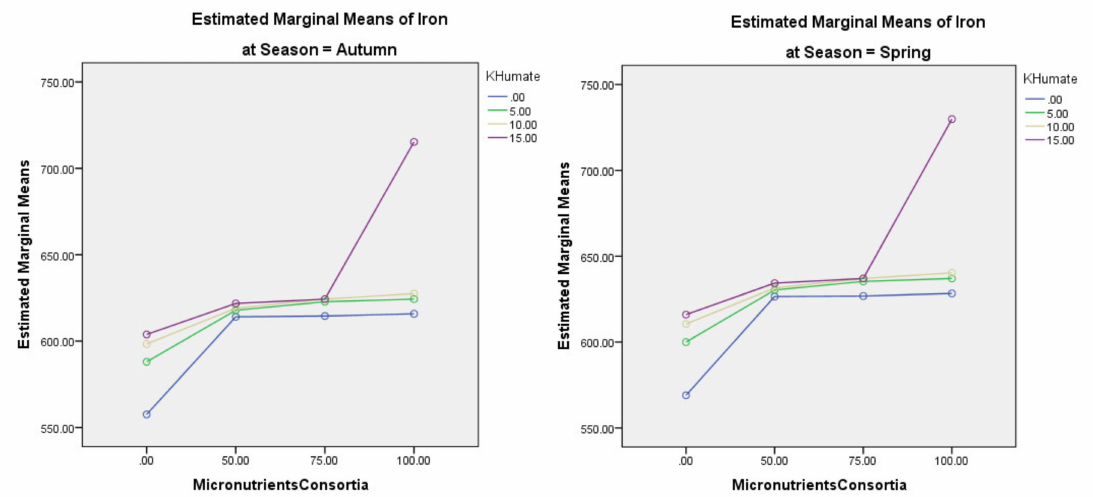
Figure 6. Interaction graphs for zinc concentration obtained in tomato fruit under K-humate and micronutrients mixture applied in the autumn and spring